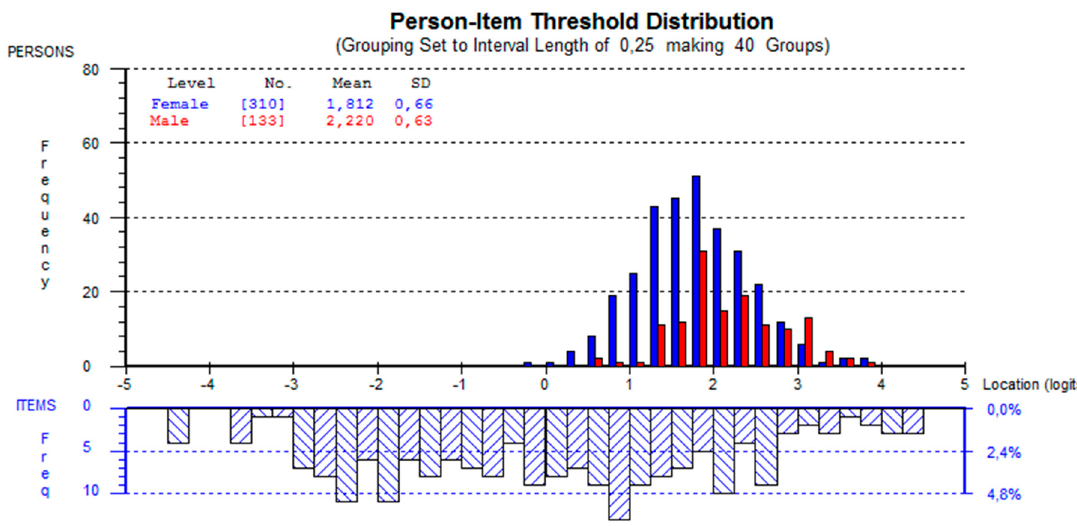
Figure 2. Item person map.